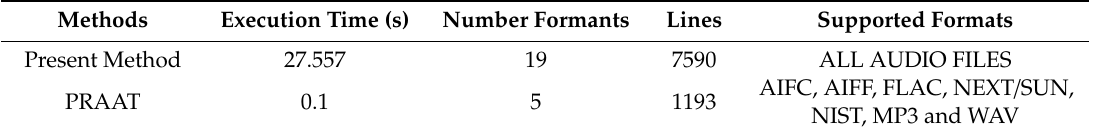
Table 11. Comparison of extracting the formants for the proposed method with the Praat